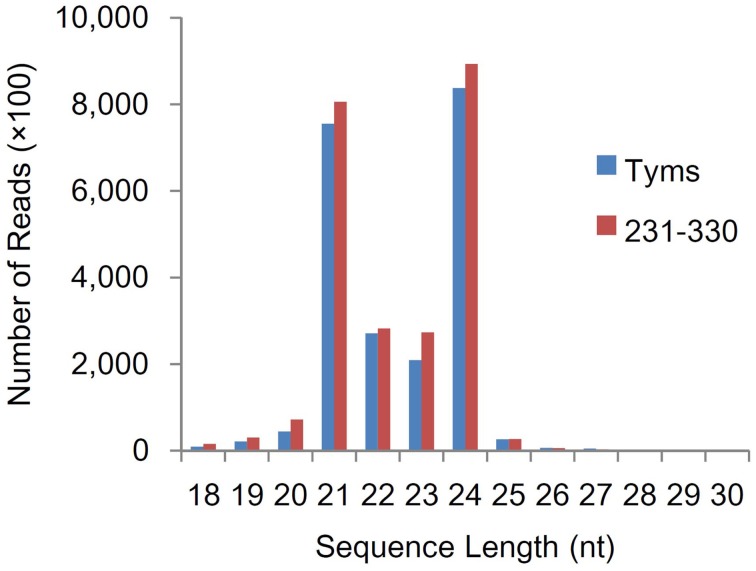
Size distribution of small RNA sequences.